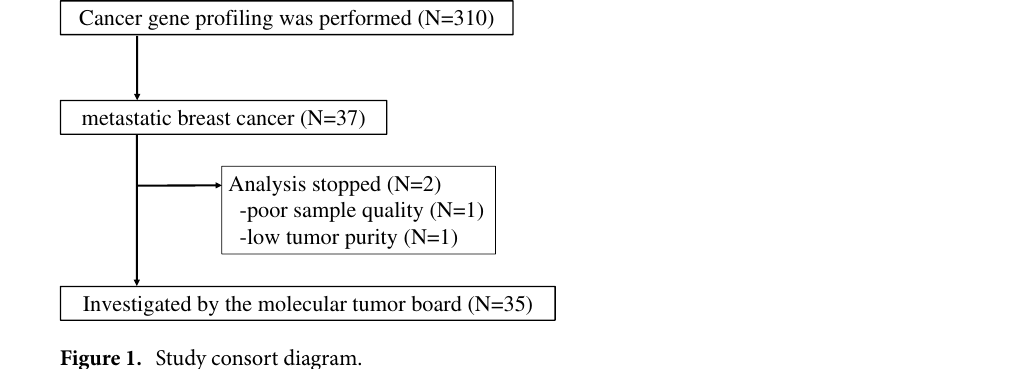
Figure 1. Study consort